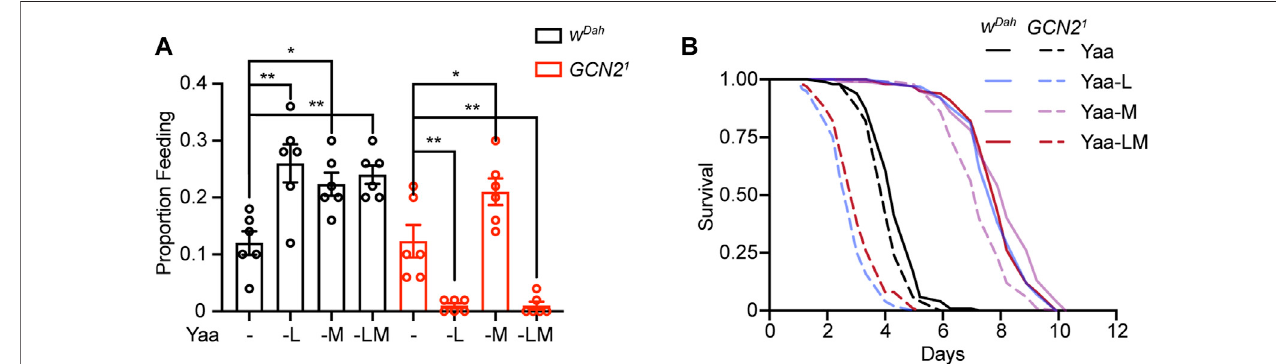
FIGURE 5 | GCN2 mutants are not able to initiate compensatory feeding in response to combined deprivation of methionine and leucine. (A) Proboscis extension assayand (B) Starvationassayof w Dah controlsand Gcn2 1 mutantfemalesundercombineddeprivation ofleucineandmethionine. (A) Feedingratesof w Dah control fl ies were signi fi cantly increased but not different to each other upon long-term (day 4) deprivation of M, L, or LM. Feeding rates of Gcn2 1 mutants were increased upon M deprivation, but strongly decreased in response to L and LM deprivation. n = 6 vials with fi ve fl ies per vial. Data are present as mean ± s.e.m. One-way ANOVA followedbyDunnett ’ smultiplecomparisons test, p valueswere adjusted formultiplecomparisons. (B) Survivalunderfullstarvationof w Dah and Gcn2 1 femalesfedfor7- days with L, M, and LM de fi cient diets followed by full starvation. w Dah control fl ies were signi fi cantly starvation resistant upon L, M, and LM deprivation: (-L: p = 1.1 × 10 − 45 , -M: p = 1.2 ×10 − 44 ,-LM: p = 9.5 ×10 − 46 ,log-ranktest). Gcn2 1 mutants weresigni fi cantlystarvationresistantupon M deprivation, but showed decreased survial upon L and LM deprivation: (-L: p = 8.4 × 10 − 23 , -M: p = 2.5 × 10 − 47 , -LM: p = 8.4 × 10 − 14 , log-rank test). n = 100 fl ies for each condition of each